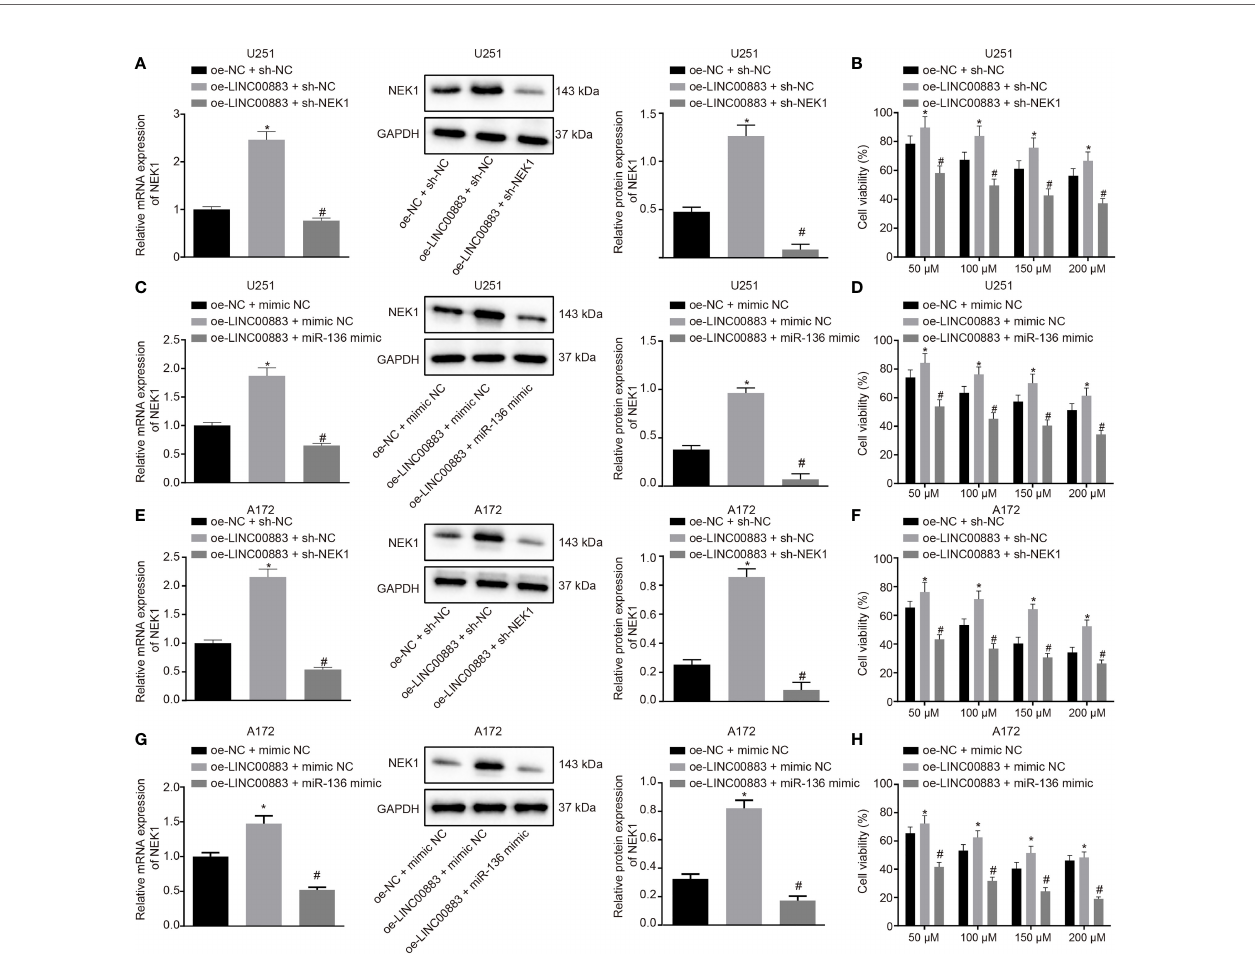
FIGURE 5 | LINC00883 blocks miR-136-dependent NIMA-related kinase 1 (NEK1) inhibition, thereby inducing drug resistance of glioma cells. (A) The NEK1 expression in U251 cell line cotransfected with oe-LINC00883 and sh-NEK1/sh-NC as examined by RT-qPCR and Western blot analysis. (B) The viability of U251 cell line cotransfected with oe-LINC00883 and sh-NEK1/sh-NC as examined by 3-(4,5-dimethylthiazol-2-yl)-2,5-diphenyltetrazolium bromide (MTT) assay. (C) The NEK1 expression in U251 cell line cotransfected with oe-LINC00883 and miR-136 mimic/NC mimic as measured by RT-qPCR and Western blot analysis. (D) The viability of U251 cell line cotransfected with oe-LINC00883 and miR-136 mimic/NC mimic as examined by MTT assay. (E) The NEK1 expression in A-172 cell line cotransfected with oe-LINC00883 and sh-NEK1/sh-NC as examined by RT-qPCR and Western blot analysis. (F) The viability of A-172 cell line cotransfected with oe-LINC00883 and sh-NEK1/sh-NC as examined by MTT assay. (G) The NEK1 expression in A-172 cell line cotransfected with oe-LINC00883 and miR-136 mimic/ NC mimic by RT-qPCR and Western blot analysis. (H) Viability of A-172 cell line cotransfected with oe-LINC00883 and miR-136 mimic/NC mimic as examined by MTT assay. * p < 0.05 vs . the oe-NC + sh-NC group; # p < 0.05 vs . the oe-LINC00883 + sh-NC. The above data were expressed as mean ± standard deviation and analyzed by one-way analysis of variance. Biological and technical experimental replicates were performed in